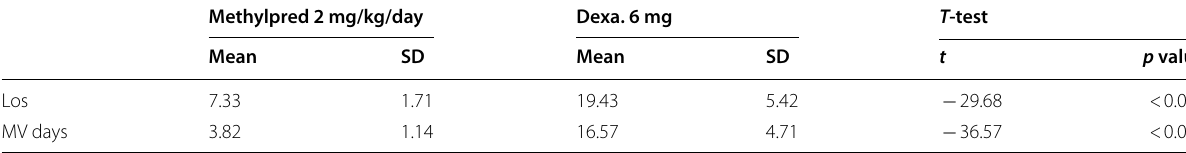
Table 3 Mechanical ventilation days and length of stay in the two groups